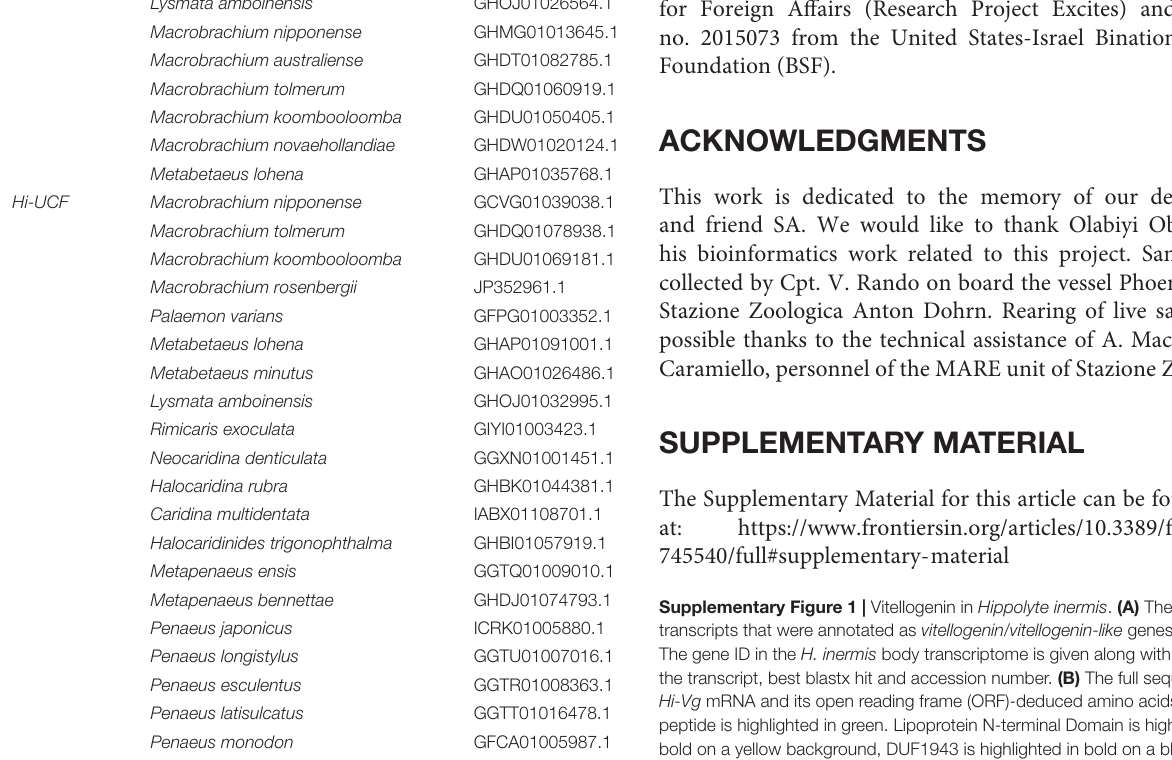
Supplementary Figure 1 | Vitellogenin in Hippolyte inermis . (A) The five longest transcripts that were annotated as vitellogenin / vitellogenin-like genes in decapods. The gene ID in the H. inermis body transcriptome is given along with the length of the transcript, best blastx hit and accession number. (B) The full sequence of Hi-Vg mRNA and its open reading frame (ORF)-deduced amino acids. The signal peptide is highlighted in green. Lipoprotein N-terminal Domain is highlighted in bold on a yellow background, DUF1943 is highlighted in bold on a blue background, DUF1081 is highlighted in bold on a pink background and von Willebrand factor (vWF) type D domain is highlighted in bold on a red background. The start (ATG) and stop (TAA) codons are shown in red and are underlined. The stop codon is also indicated with an asterisk. 5 (cid:48) (top) and 3 (cid:48) (bottom) UTRs are highlighted with a gray background. The predicted domains of the putative protein were inferred from its deduced amino acids sequence using SMART (http://SMART.embl-heidelberg.de). Supplementary Figure 2 | Uncharacterized sex-specific genes in the eye Hippolyte inermis . (A) Homolog sequences of Hi-UCMe and Hi-UCFe in other decapod species found by blastx and tblastn in the NCBI server. Accession numbers of the homolog sequences from each species are given for each gene ID. (B) Normalized read counts of (Left) Male-related gene ( Hi-UCMe ) and (Right) Female-related gene ( Hi-UCFe ) in different stages of H. inermis : immature ( n = 2), male ( n = 3), young female ( n = 3) and mature female ( n = 3). Error bars represent standard error of the means. ∗ P ≤ 0.05. Supplementary Table 1 | Differentially expressed transcripts that were assigned a binary pattern in H. inermis body and eye transcriptomes. Trinotate and Blast2GO annotations are given. Supplementary Table 2 | Differentially expressed transcripts between every possible contrast (I vs. M, I vs. YF, I vs. MF, M vs. YF, M vs. MF and YF vs. MF) in the H. inermis body transcriptome. Read counts in each sample in each stage, linear fold change, pattern (upregulation/downregulation), Trinotate and Blast2GO annotations are given. Supplementary Table 3 | Differentially expressed transcripts between every possible contrast (I vs. M, I vs. YF, I vs. MF, M vs. YF, M vs. MF and YF vs. MF) in the H. inermis eye transcriptome. Read counts in each sample in each stage, linear fold change, pattern (upregulation/downregulation), Trinotate and Blast2GO annotations are